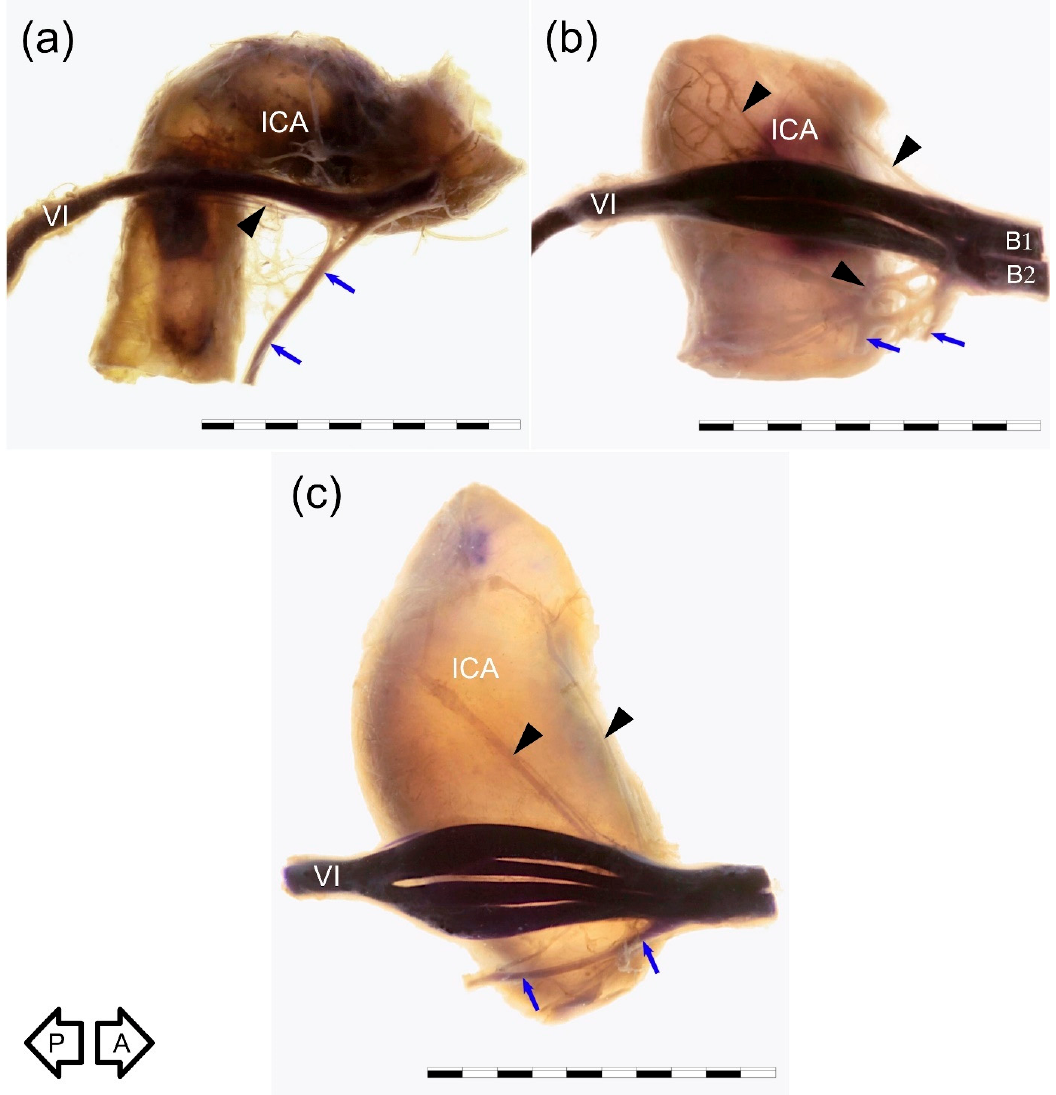
Figure 2. Abducens nerve (VI) visualized at the crossing point with the cavernous carotid artery (ICA). Lateral view of the specimens harvested from the right CS. Specimens were prepared using a whole-mount nerve staining technique (Sihler’s stain). Relation of the nerve to the ICP is also presented. Blue arrows mark a well-developed anterior bundle of the sympathetic nerve fibers joining the inferior aspect of the AN. Black arrows show tiny nerve bundles joining the medial aspect of the nerve. ( a ) Typical variant with single nerve. ( b ) “Early branching” of the AN. In this variant, the nerve was divided into two separate branches (B1 and B2) at the contact point with the cavernous part of the ICA posterior vertical segment’s lateral wall. In this case, separate AN branches continued to the superior orbital fissure. ( c ) Variant with AN divided into four separate rootlets at the point of contact with the posterior vertical segment of the cavernous ICA. Black arrows indicate anterior (A) and posterior (P) directions. Scale bar corresponds to 10 mm.